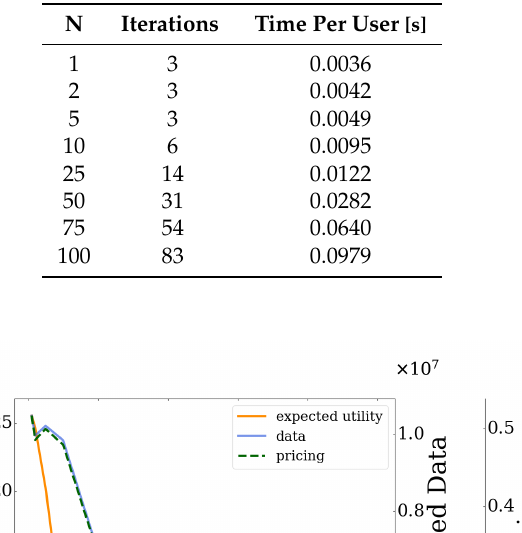
Table 2. Algorithm’s execution time per user for a different number of users.